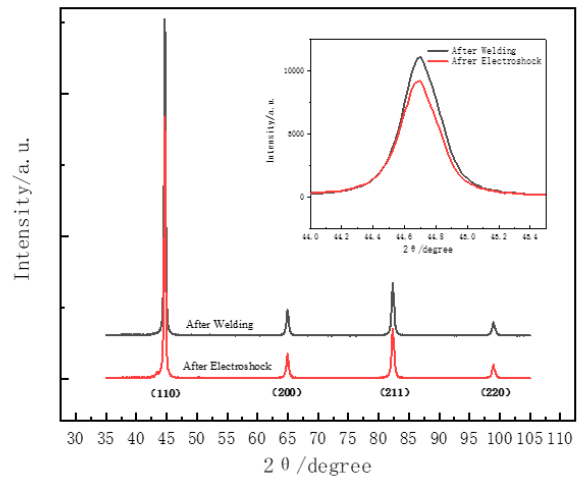
Figure 17. XRD diffraction spectrum diagram.